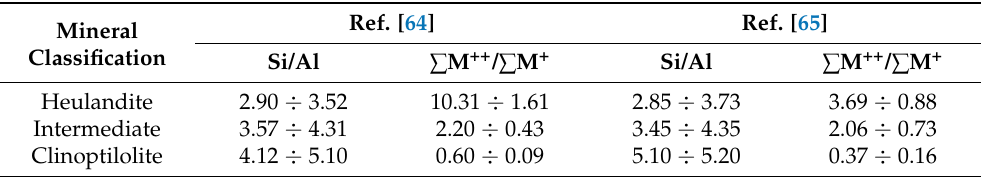
Table 1. Ranges of composition changes between definitely heulandites, intermediate minerals, and definitely clinoptilolites [64,65]. Adapted with permission from Drebushchak, V.A. et al., Thermochim Acta ; Elsevier Science B.V., 2000